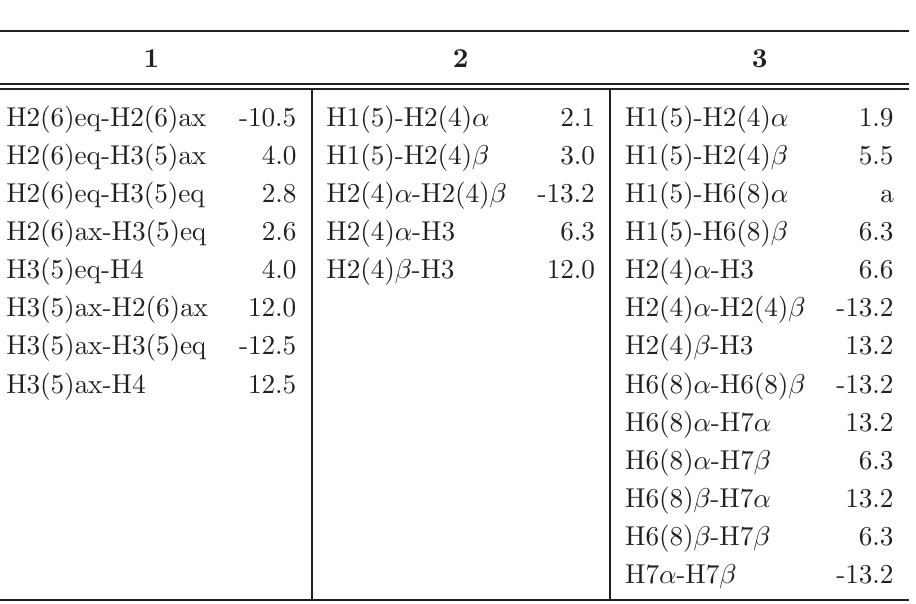
Table 2 Coupling constants ( J , Hz) deduced from the analysis of the 1 H NMR spectra of compounds 1 - 3. a Not determined owing to the low resolution of the